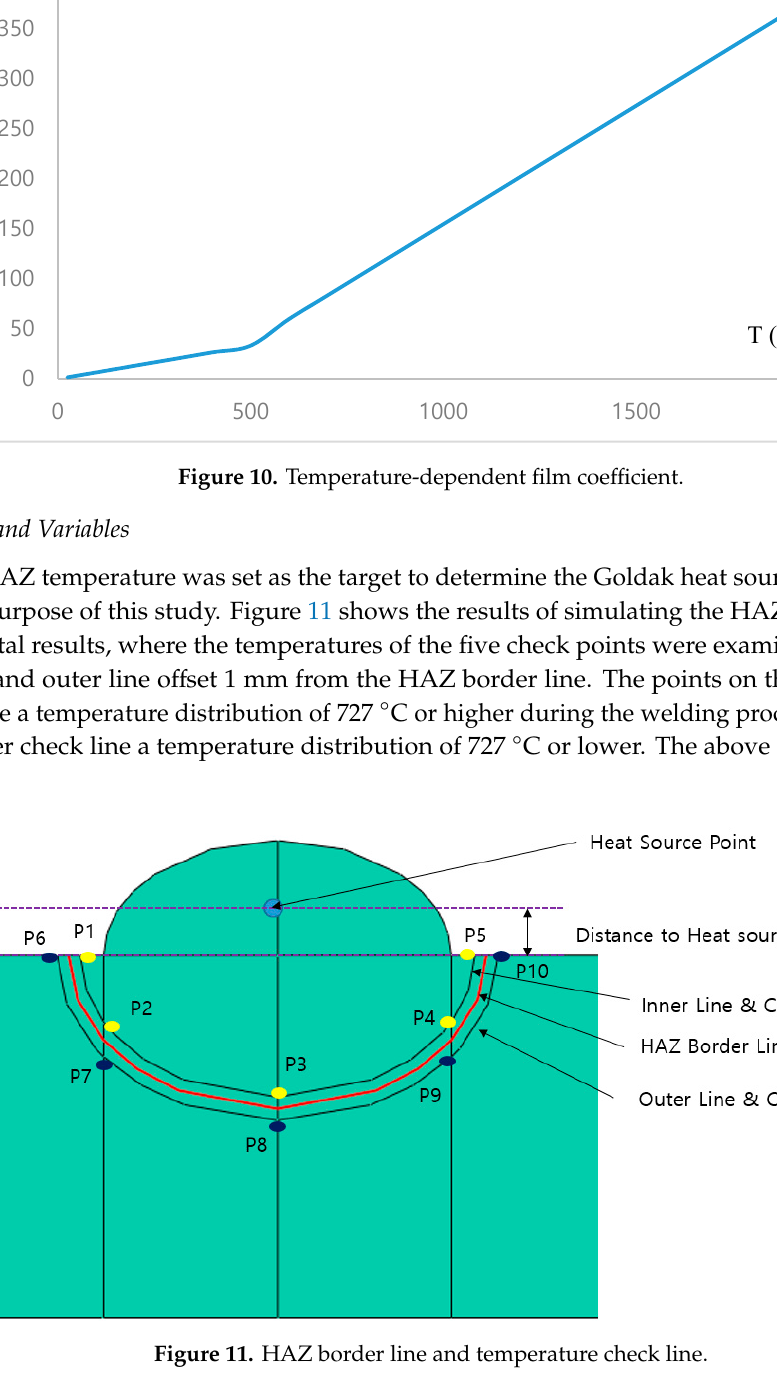
Figure 11. HAZ border line and temperature check line.